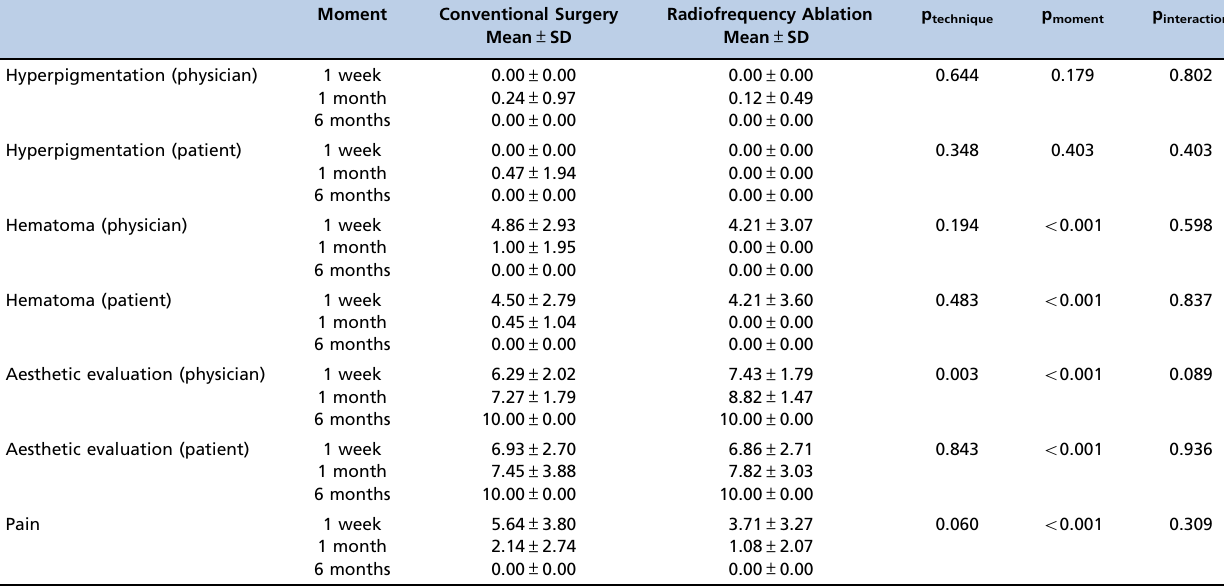
Table 2 - Subjective assessments conducted by patients and physicians of the surgical techniques over time.